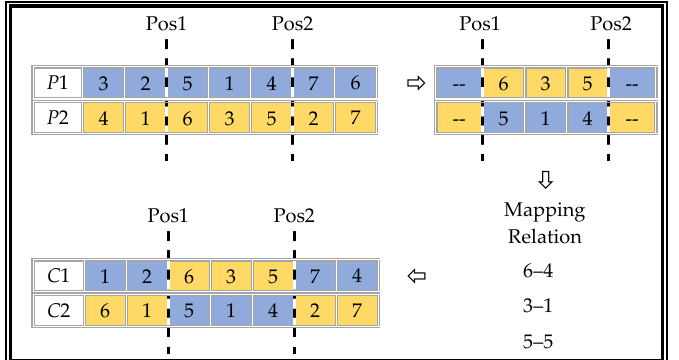
Figure 9. Schematic diagram of PMX operation.